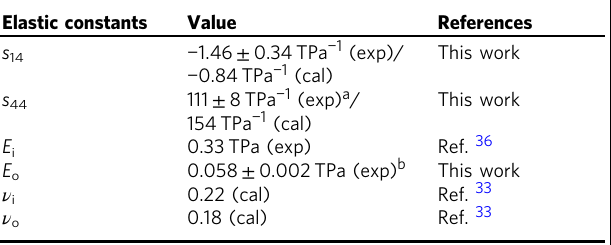
Table 1 Elastic constants of bilayer MoS 2 Elastic